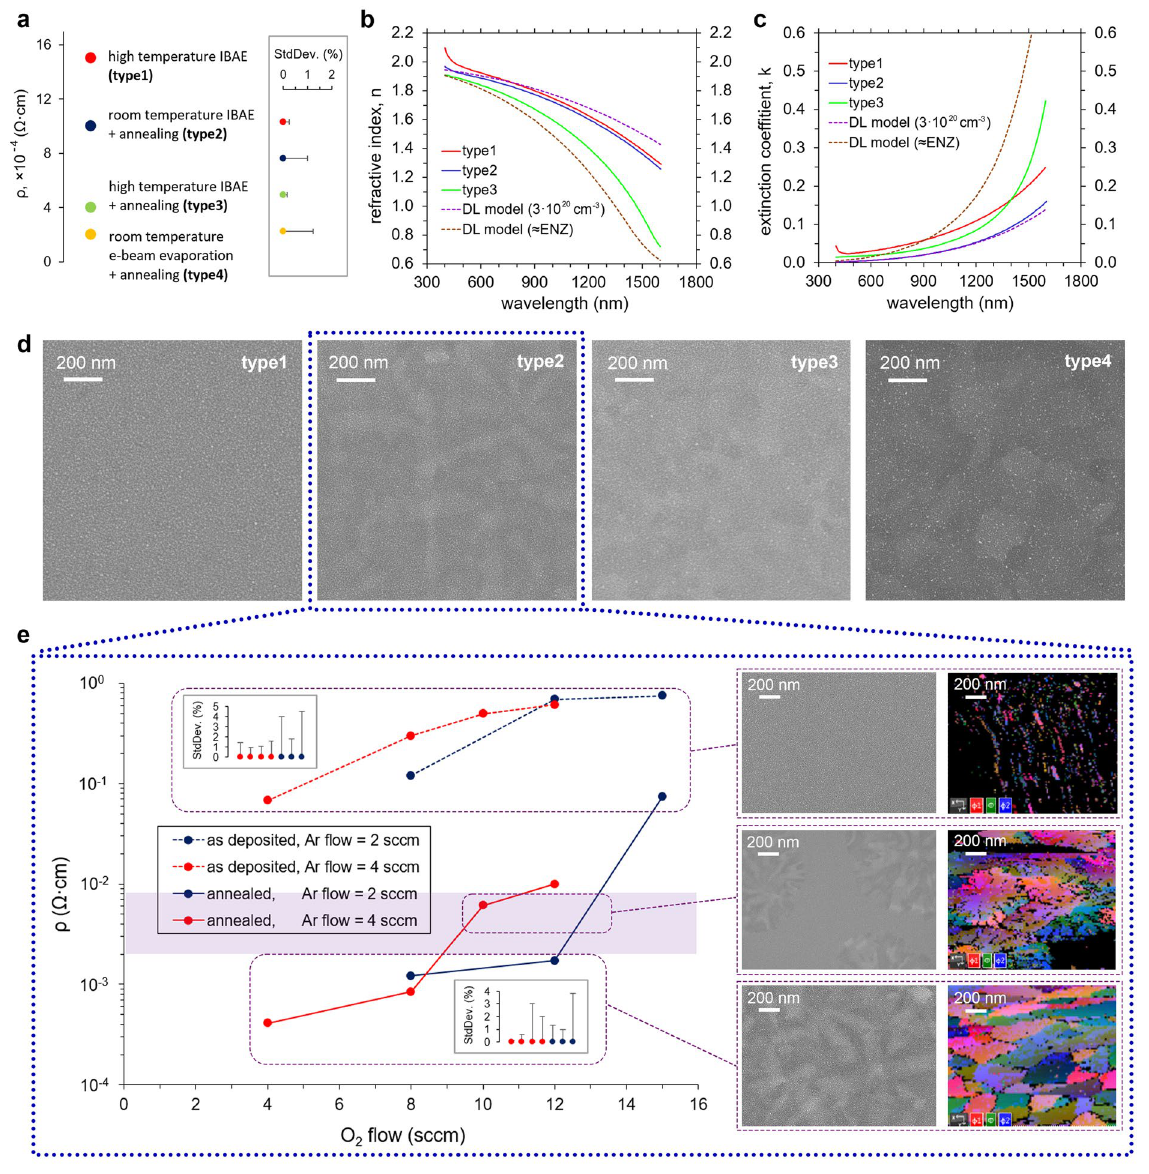
Figure 1. ( a ) ITO films resistivity distribution for proposed four deposition technique; ITO films ( b ) refractive index and ( c ) extinction coefficient dependences on wavelength; ( d ) High-resolution SEM images of the ITO films surface; ( e ) Room temperature IBAE + annealing ITO films resistivity dependence on Ar/O 2 mixture composition during evaporation. Resistivity standard deviation error bars are shown for each point of the graphs from left to right correspondingly. Selected areas show the surface (SEM images) and crystallography (SEM EBSD maps) of films with different resistivity